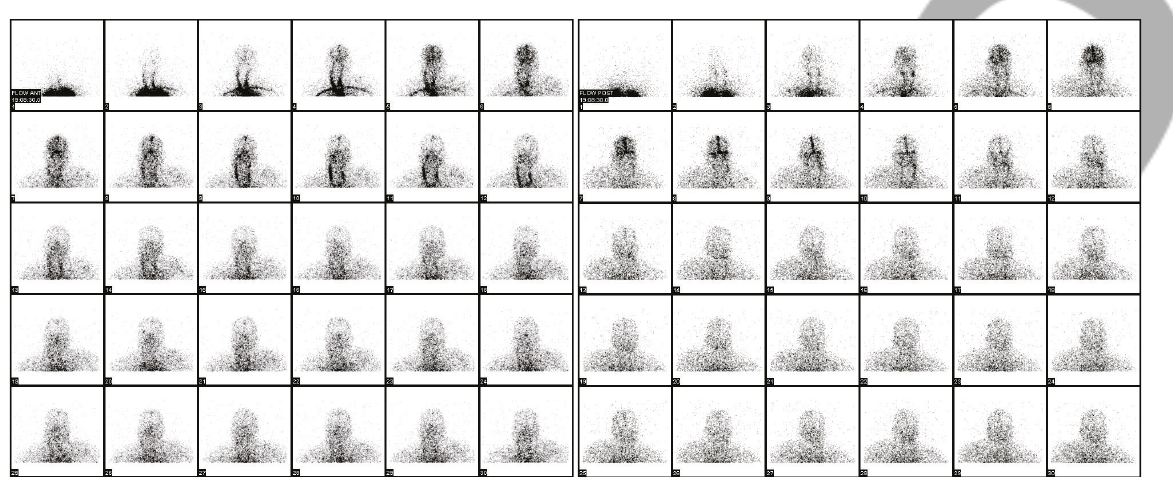
Figure 2: Patient #2. RCPS showing anterior and posterior views with no cerebral blood flow.